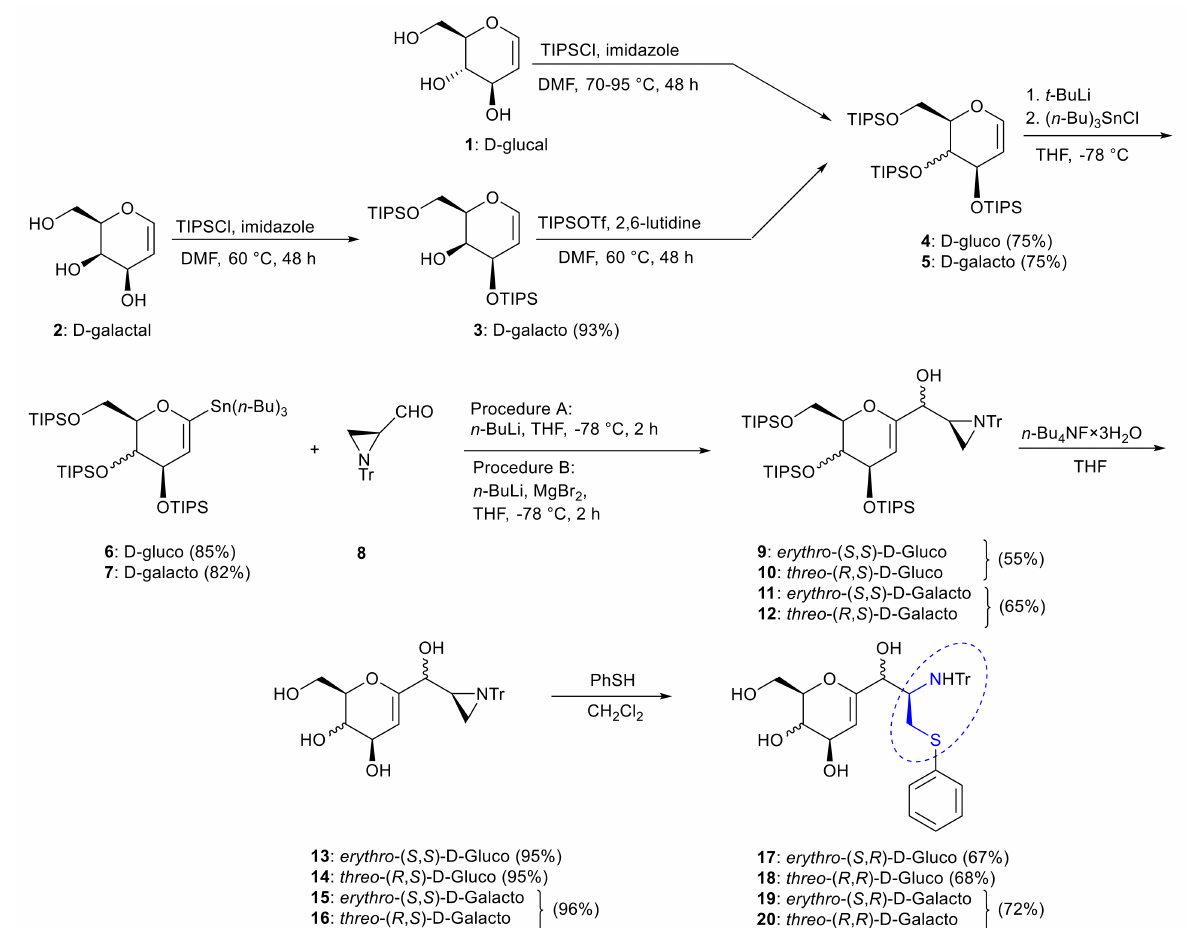
Scheme 1. Synthesis of C -glycosyl-aminoethyl sulfide derivatives.